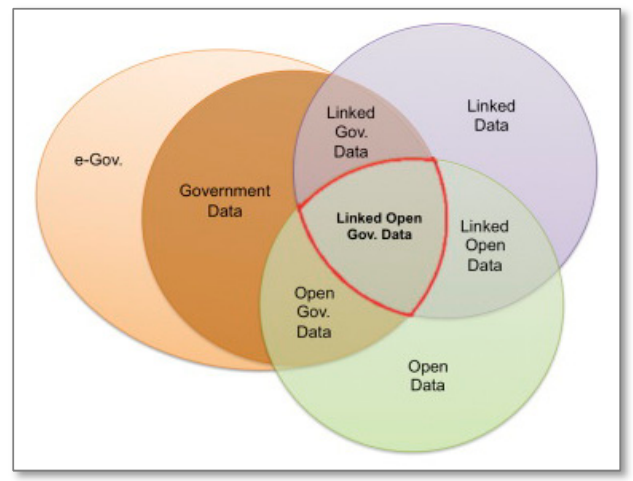
Figure 8. Relationship between open, government and linked data. Reproduced with permission from publisher of reference [26].